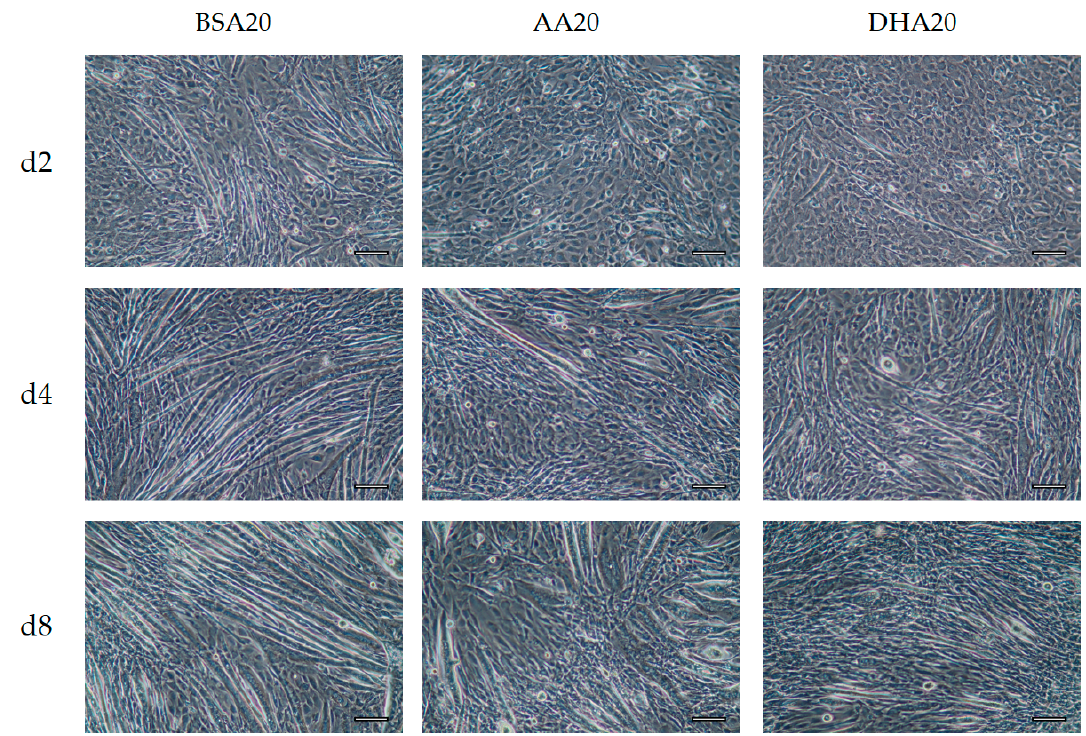
Figure 5. The phase contrast images of C2C12 differentiation stages under different treatments at different time points (Day 2 (d2), Day 4 (d4) and Day 8 (d8)). BSA20, AA20 and DHA20 treatments were added only on the first 2 days and then switched with normal DM medium till day 8. Scale bar 100 μ m.